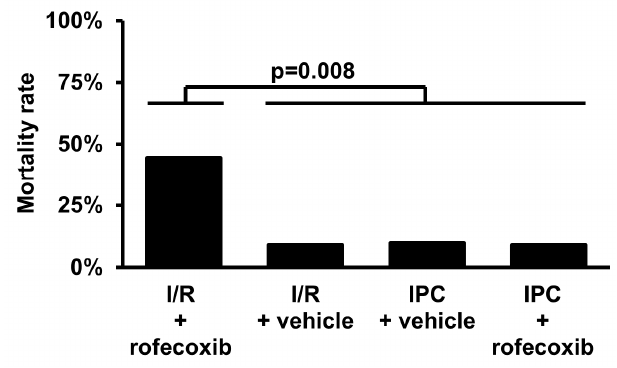
Figure 4. Rofecoxib treatment increased the mortality rate in the ischemia/reperfusion (I/R) group in vivo . When compared to the pooled data of other groups, the mortality-increasing effect of